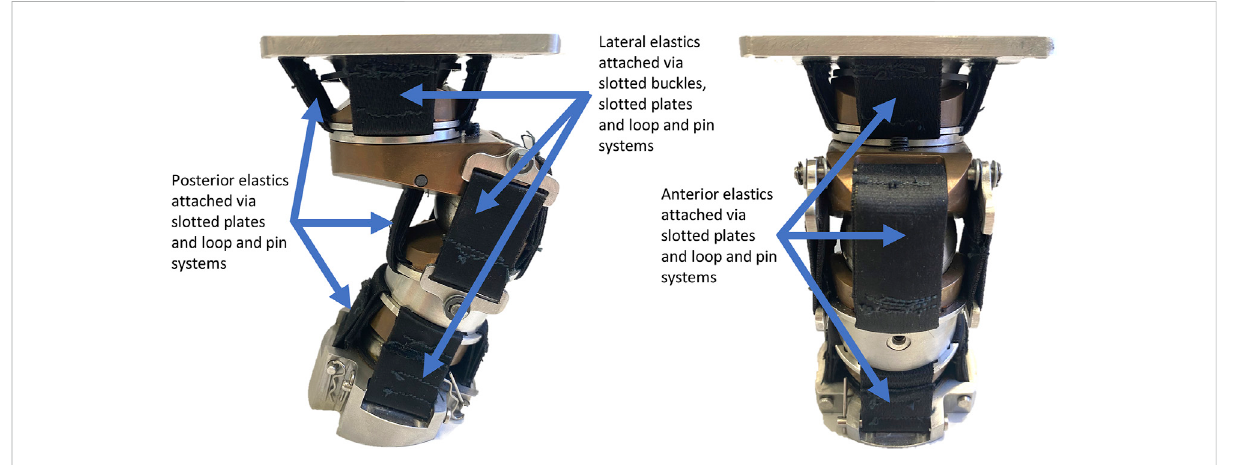
LUSN fully assembled in the neutral posture with elastic